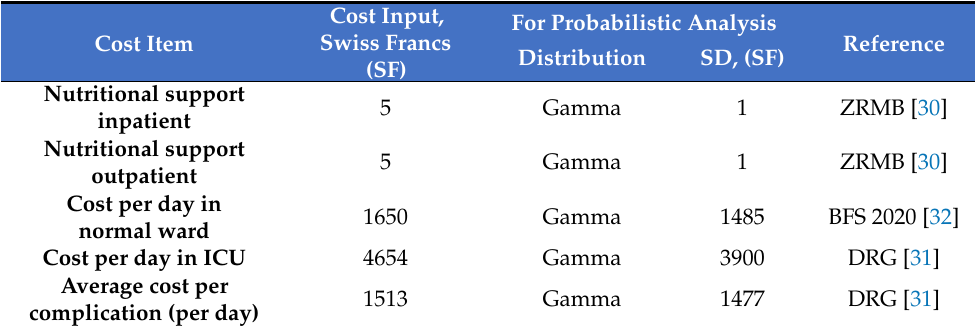
Table 1. Cost input values for the health economic model with monetary costs expressed in Swiss francs (SF). Cost Input, For Probabilistic Analysis Swiss Francs Cost Item Distribution SD, (SF) (SF)